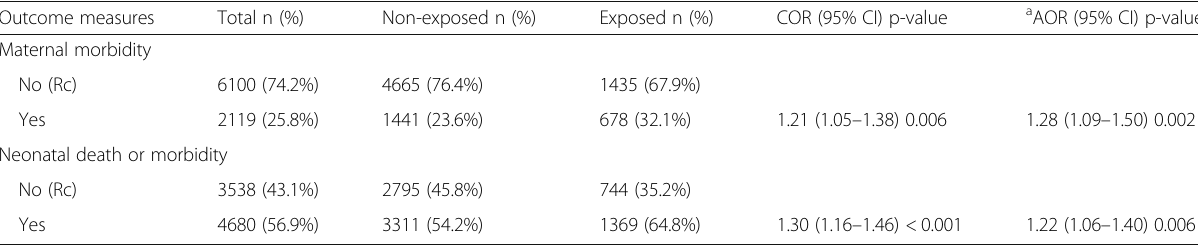
Table 2 Associations between exposure to Mwanamphepo during pregnancy and adverse pregnancy outcomes (Mixed-effects model, adjusted for